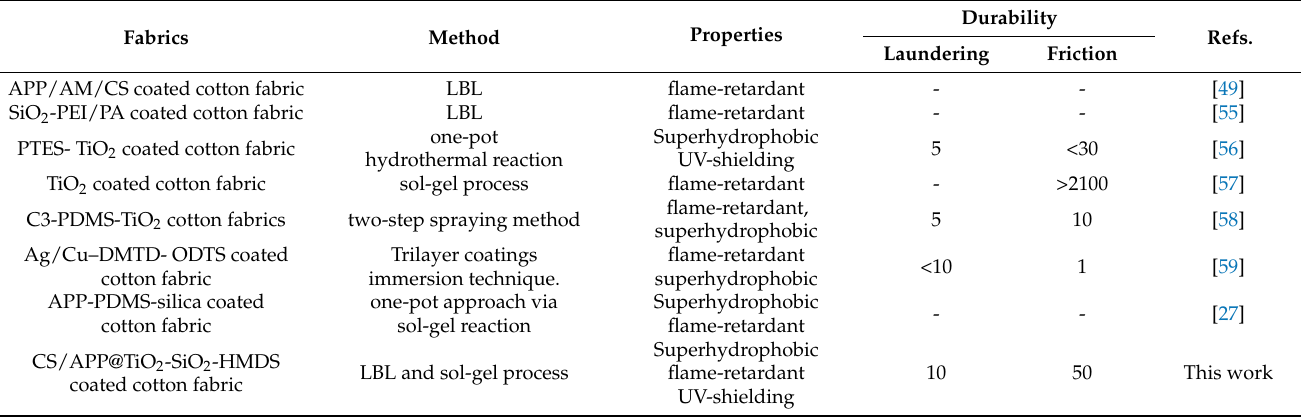
Table 6. Comparison of preparation and performance of various superhydrophobic, flame-retardant cotton fabrics reported by other researchers and in this work